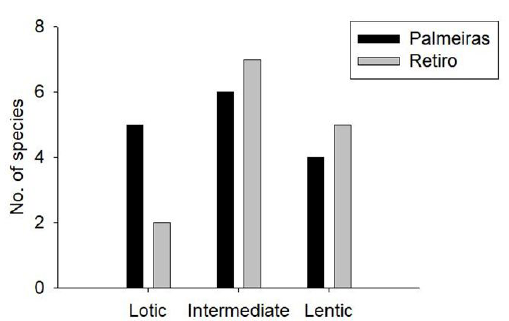
Figure 4. Abundance per development stage for the fish fauna associated to macrophyte banks in the distinct compartments of Palmeiras (A) and Retiro (B) SHPs reservoirs, Sapucaí-Mirim River (SP,